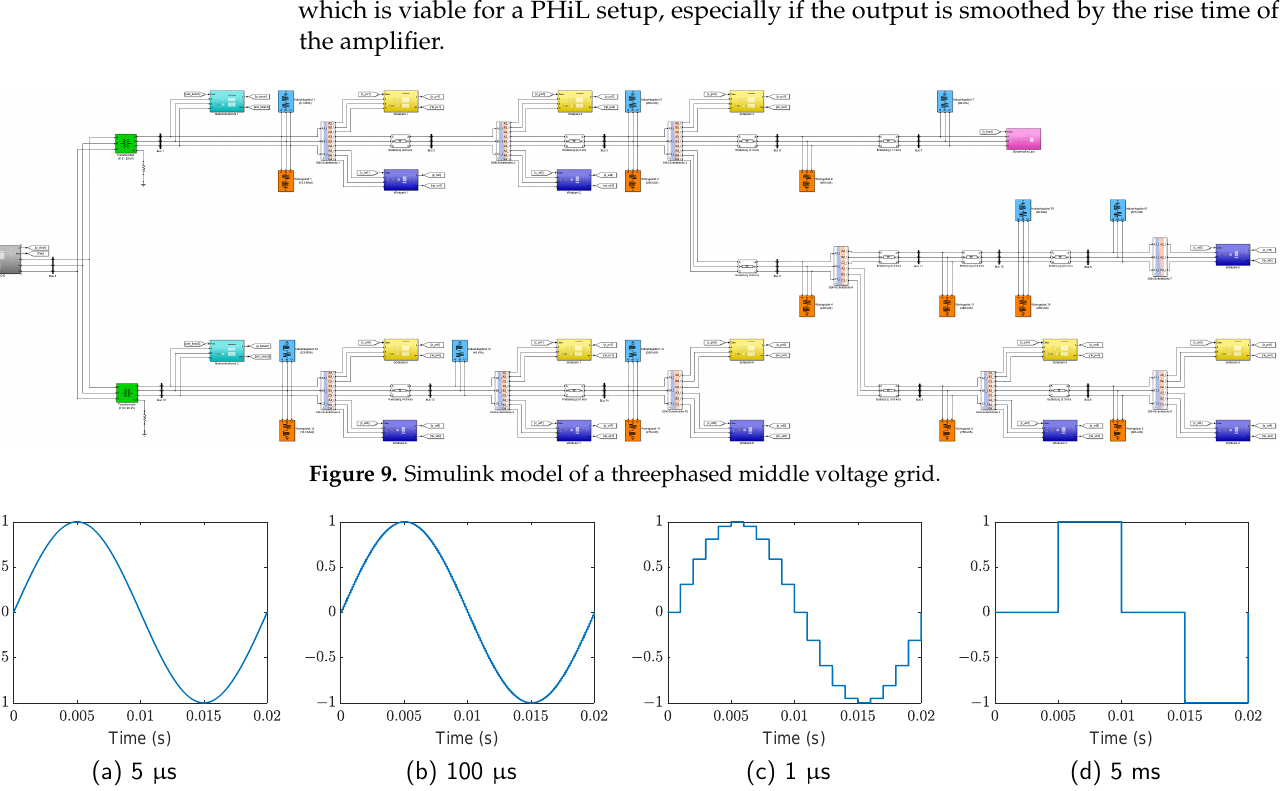
Figure 10. Discretised sinusoidal signal with a time step of 5 µ s ( a ), 100 µ s ( b ), 1 ms ( c ), and 5 ms ( d